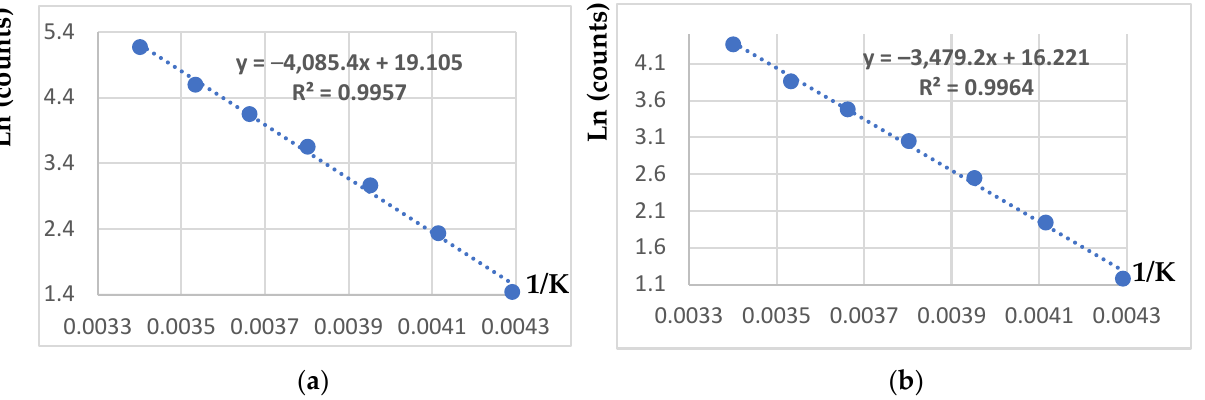
Figure 7. The dependence of the natural logarithm of the background current of the sensor with the corresponding electrolyte sample on the reciprocal temperature, along the abscissa axis there is 1/K, along the ordinate axis there is value of Ln (counts), the count is proportional to the current value in μ A: ( a ) For the electrolyte sample #1 [BMIM][ I] /PC /LiI; ( b ) For the electrolyte sample #3 PC/LiI.